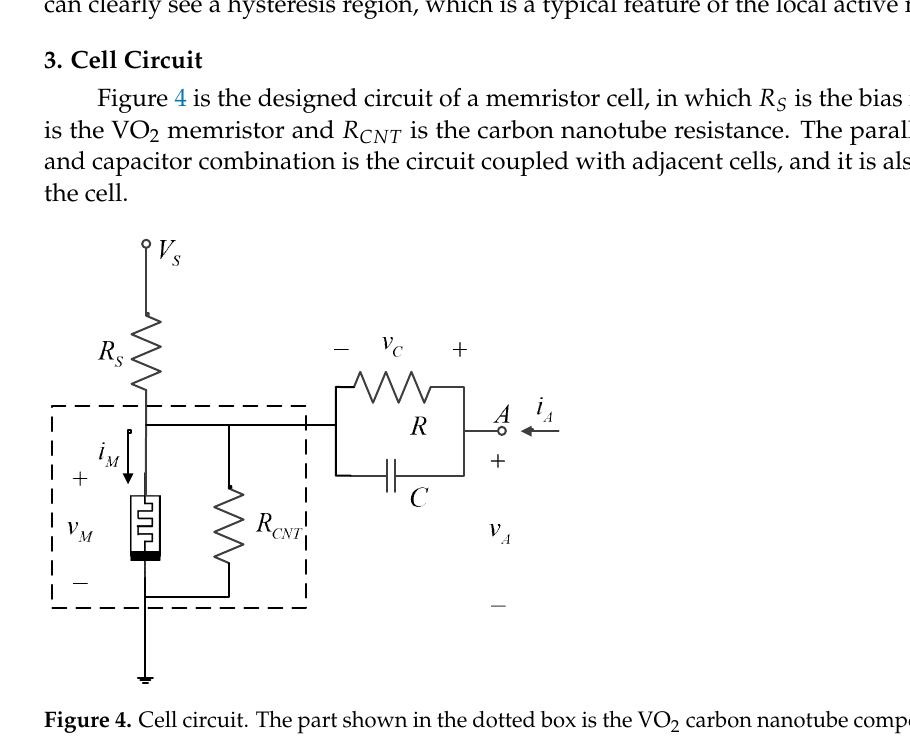
Figure 3. Quasi-static volt-ampere characteristics of the VO 2 carbon nanotube composite device.